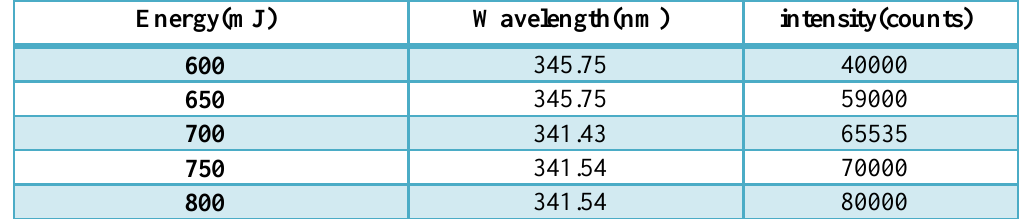
Fig.13: The emission spectra of laser induced holmium plasma with different laser energies and (10 Hz) repetition rate. Table1: The laser parameters used in the first group at (1 Hz) repetition rate with wavelength and intensity.